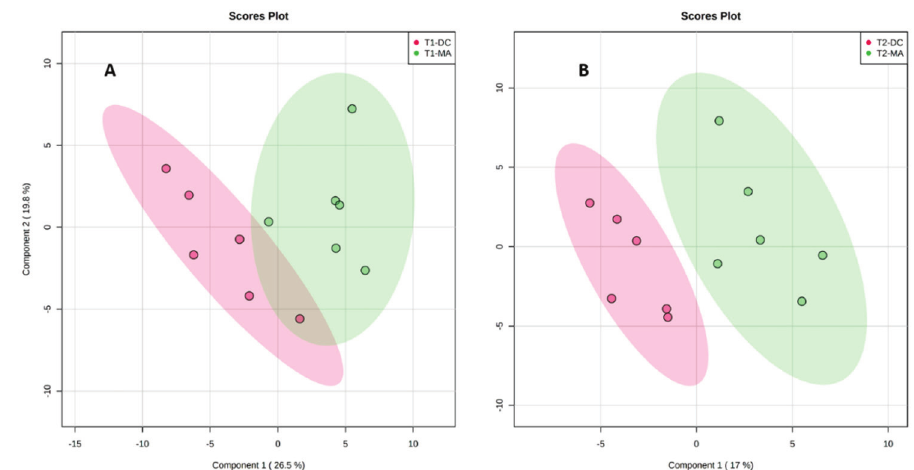
Figure 4. Partial least-squares-discriminant analysis (PLS-DA) for ( A ) samples before the rainy event (T1) and ( B ) samples after the rainy event (T2) in both substrates (MA and DC).